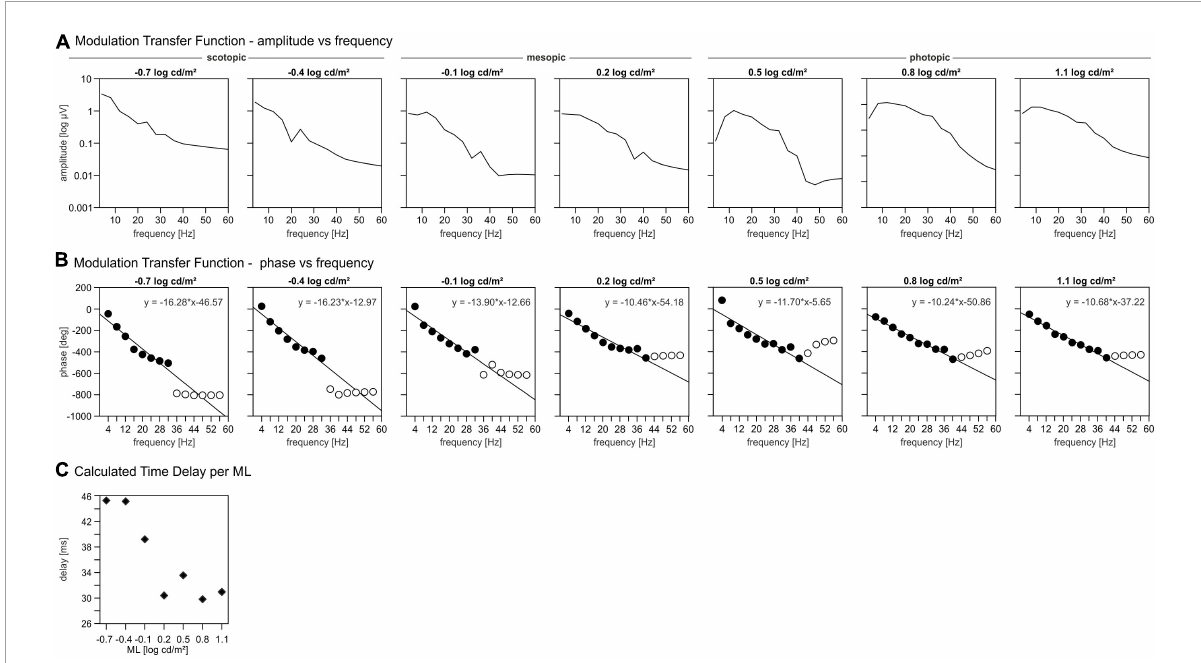
FIGURE5 Modulation transfer functions (MTFs). (A) Amplitudes of the signal per mean luminance (ML) as function of the temporal frequency. (B) Phases of the signal per ML as function of the temporal frequency. Closed symbols: phases included in further analysis for delay, open symbols: phases excluded for further delay analysis. (C) Calculated time delay per